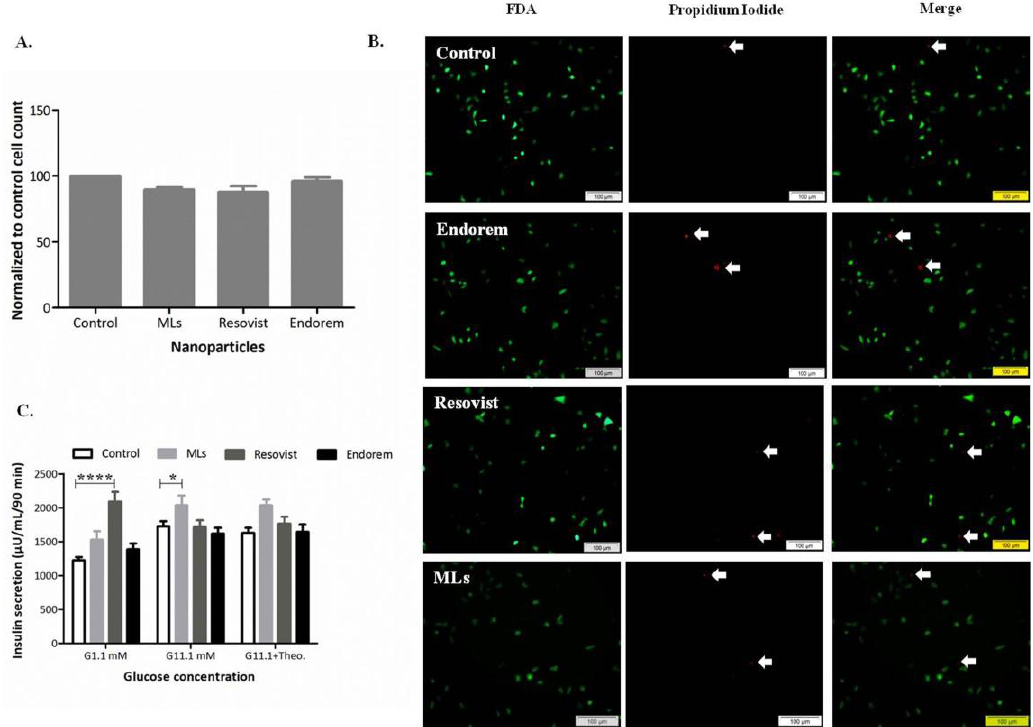
Figure 2. Cell proliferation and viability post labeling: ( A , B ) Total cell count post-labeling was comparable to non-labeled samples. ( B ) Viability with fluorescein diacetate (FDA)/Propidium Iodide staining indicated no negative effect on the cells. ( C ) D -glucose-stimulated insulin secretion did not alter when cells were labeled with Endorem. However, Resovist labeled cells at 1.1 mM and ML labeled cells at 11.1 mM glucose concentration showed an increase in the insulin secretion. Scale bar: 100 µ m; data expressed in mean ± standard deviation (SD).